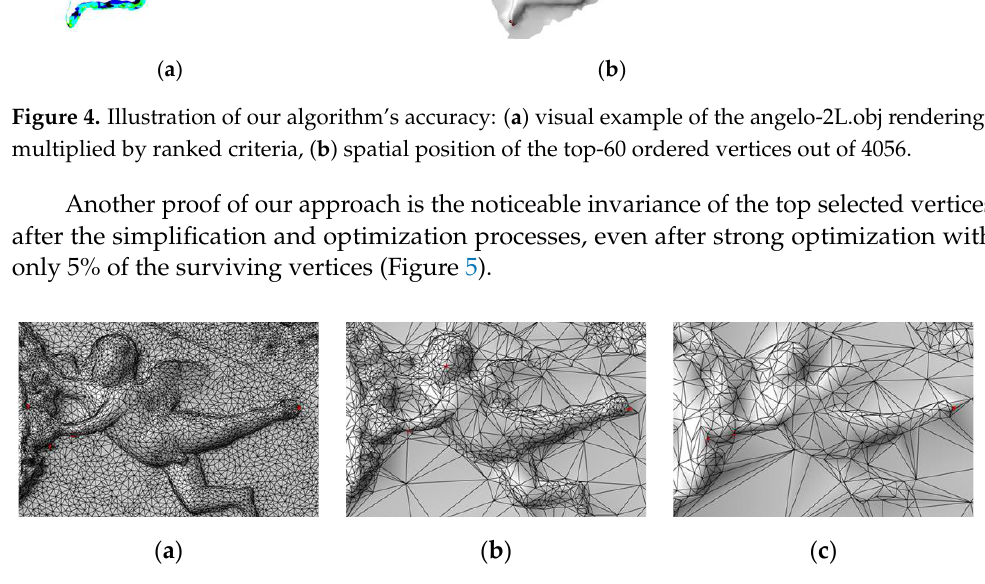
Figure 5. Red dots illustrate the invariance of vector 𝐯 I to different strengths of optimization: ( a ) original 3D mesh without deletions, ( b ) 80% deleted vertices and ( c ) 95% deleted vertices.